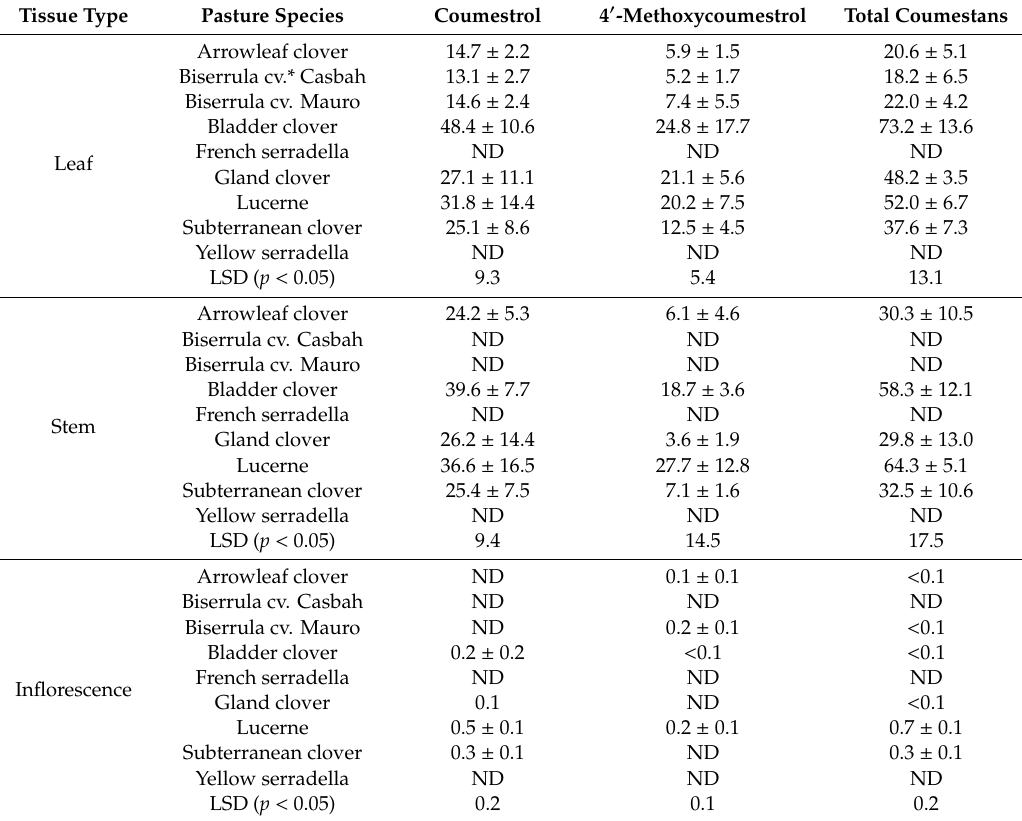
Table 1. The concentration of coumestrol and 4 (cid:48) -methoxycoumestrol (mg kg − 1 ) at physiological maturity in selected annual pasture legume